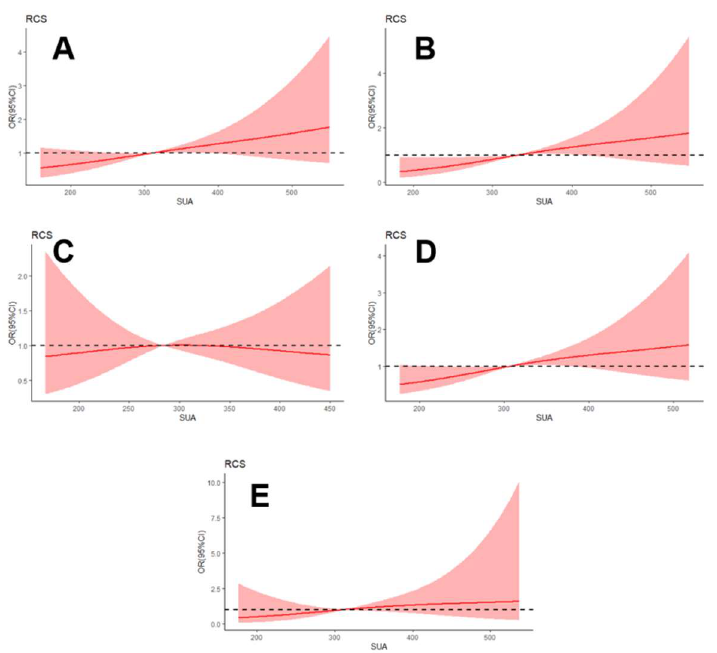
Figure 3. Relationship between serum uric acid level and diabetic peripheral neuropathy in total patients ( A ), male subgroup ( B ), female subgroup ( C ), younger subgroup ( D ), and older subgroup ( E ), respectively, using restricted cubic splines with 3 knots (at the 10th, 50th, and 90th percentiles). The model (model 2) was adjusted for gender, age, duration of diabetes, body mass index, glycated hemoglobin (HbA1c), hypertension, smoking, total cholesterol, triglyceride, high-density lipoprotein cholesterol, low-density lipoprotein cholesterol, and free thyroxine (FT4). In the gender subgroup, the model is not adjusted for the stratification variable. The solid line indicates the odds ratio (OR), while the shadow indicates 95% CIs. The horizontal dashed line is the reference line (OR = 1). Abbreviations: RCS, restricted cubic splines; SUA, serum uric acid.